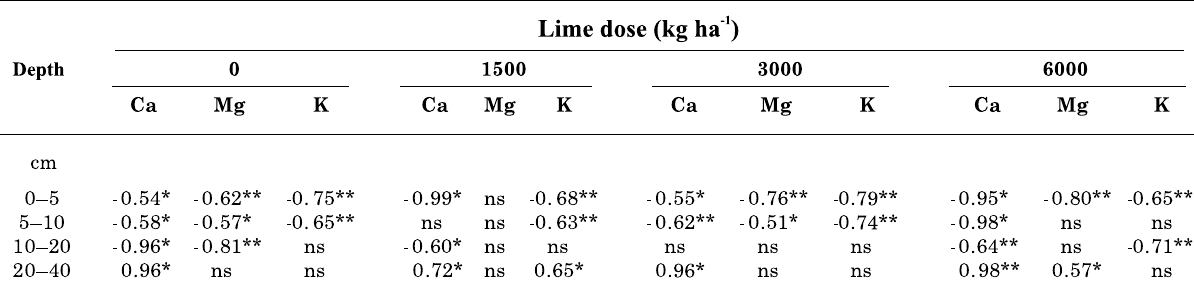
* and ** significant at 5 and 1% by the t test, respectively; ns: non significant.